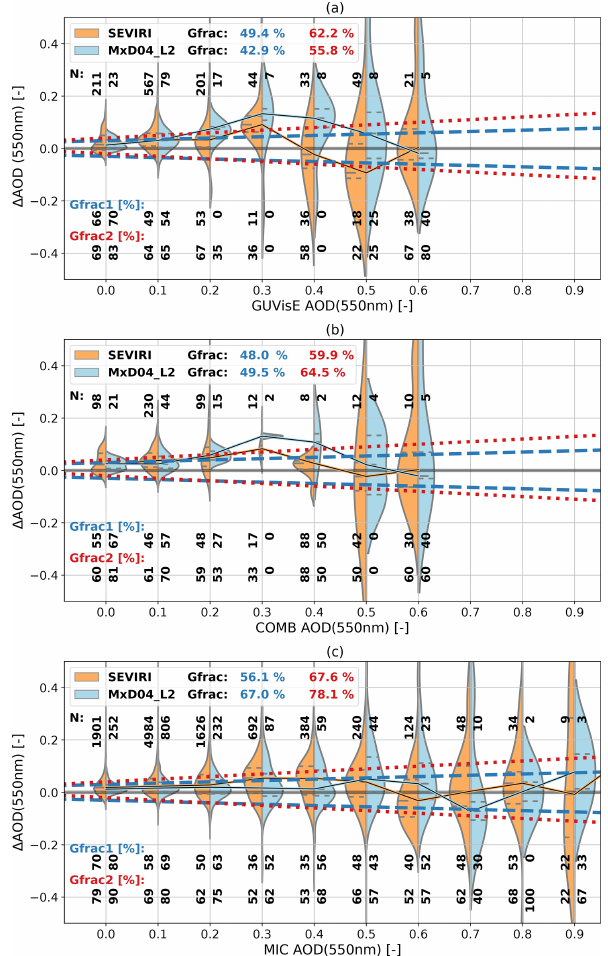
Figure 4. Comparison of AOD at 550nm from the (a) GUVisE, (b) COMB, and (c) MIC reference datasets versus the SEVIRI and MODIS AOD products. The two-sided violin plots indicate the dis- tribution of the difference for bins of 0.1 in AOD. The median of each bin is connected with a solid line to visualize the development of the bias. The dashed blue and dotted red lines indicate the ex- pected error limits for the MODIS AOD products. It is expected that at least 67% of data points fall into the expected error limits. Gfrac1 and Gfrac2 are the actual percentages of data points lying within the error limits, calculated for each bin, and as the total for both the SEVIRI and MODIS AOD